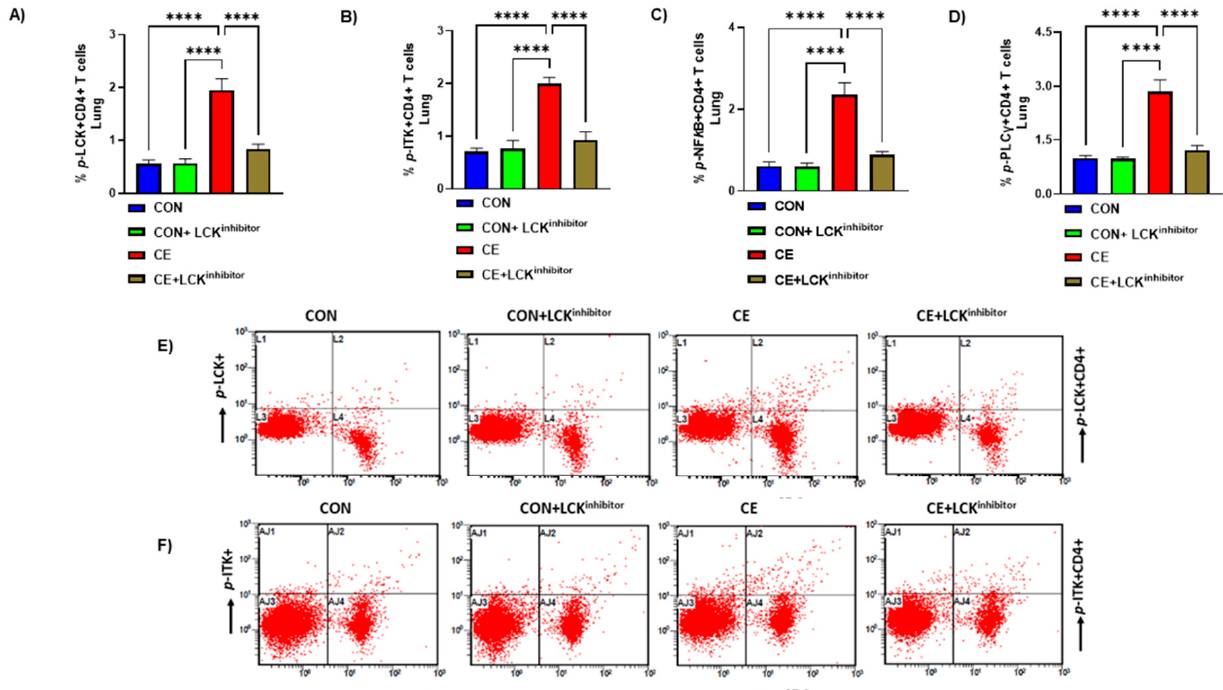
Figure 1. Activation of LCK signaling and its mitigation by LCK inhibitor in CD4+ T cells of CE- exposed allergic mice. ( A ) % p -LCK+CD4+ T cells, ( B ) % p -ITK+CD4+ T cells, ( C ) p -NF k B+CD4+ T cells, ( D ) p -PLC γ +CD4+ T cells, ( E ) Flow plot with representative depiction of double positive immunostaining in CD4+ T cells, i.e., p -LCK+ immunoreactivity in CD4+ T cells, and ( F ) Flow plot with representative depiction of double positive immunostaining in CD4+ T cells, i.e., p -ITK+ immunoreactivity in CD4+ T cells. Data are presented as mean ± SE, n = 6/group. **** p < 0.0001.